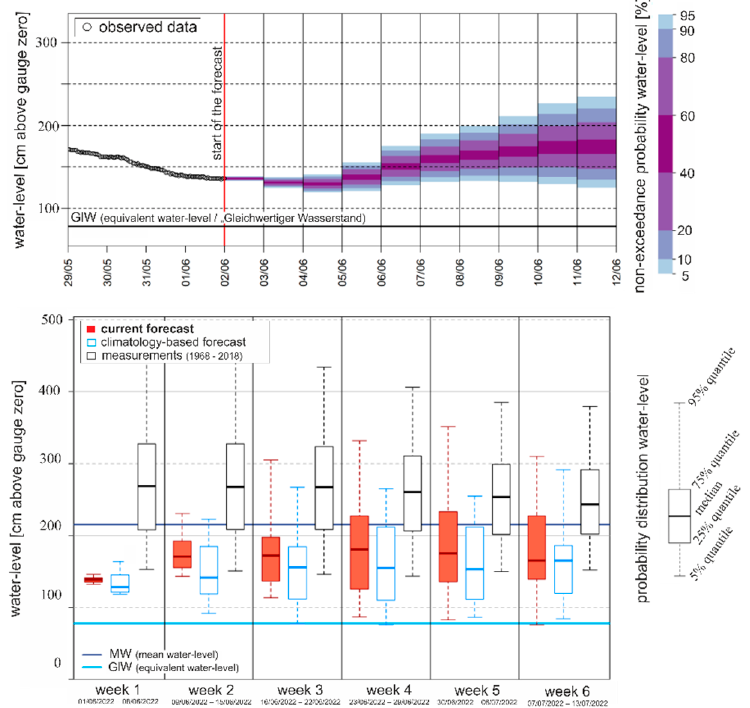
Figure 4. Example of a 10-day forecast (upper part) and a 6-week forecast (lower part) for gauge Kaub/Rhine initialized on 2 June 2022.